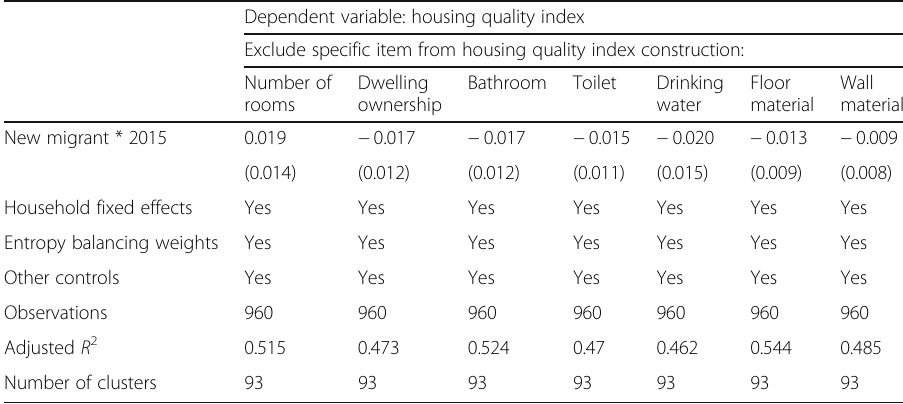
Table 9 Sensitivity of results of impact of having a new migrant on housing quality index using different specifications to construct index, weighted least